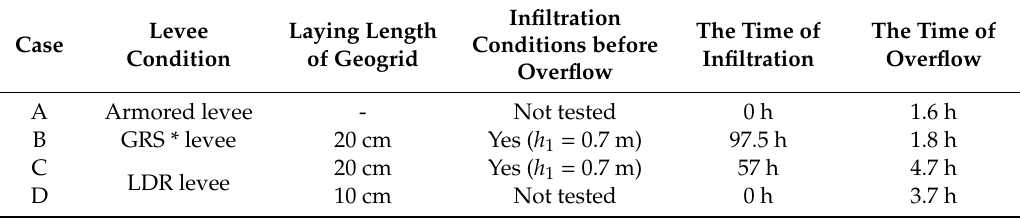
Table 1. Experimental conditions for model